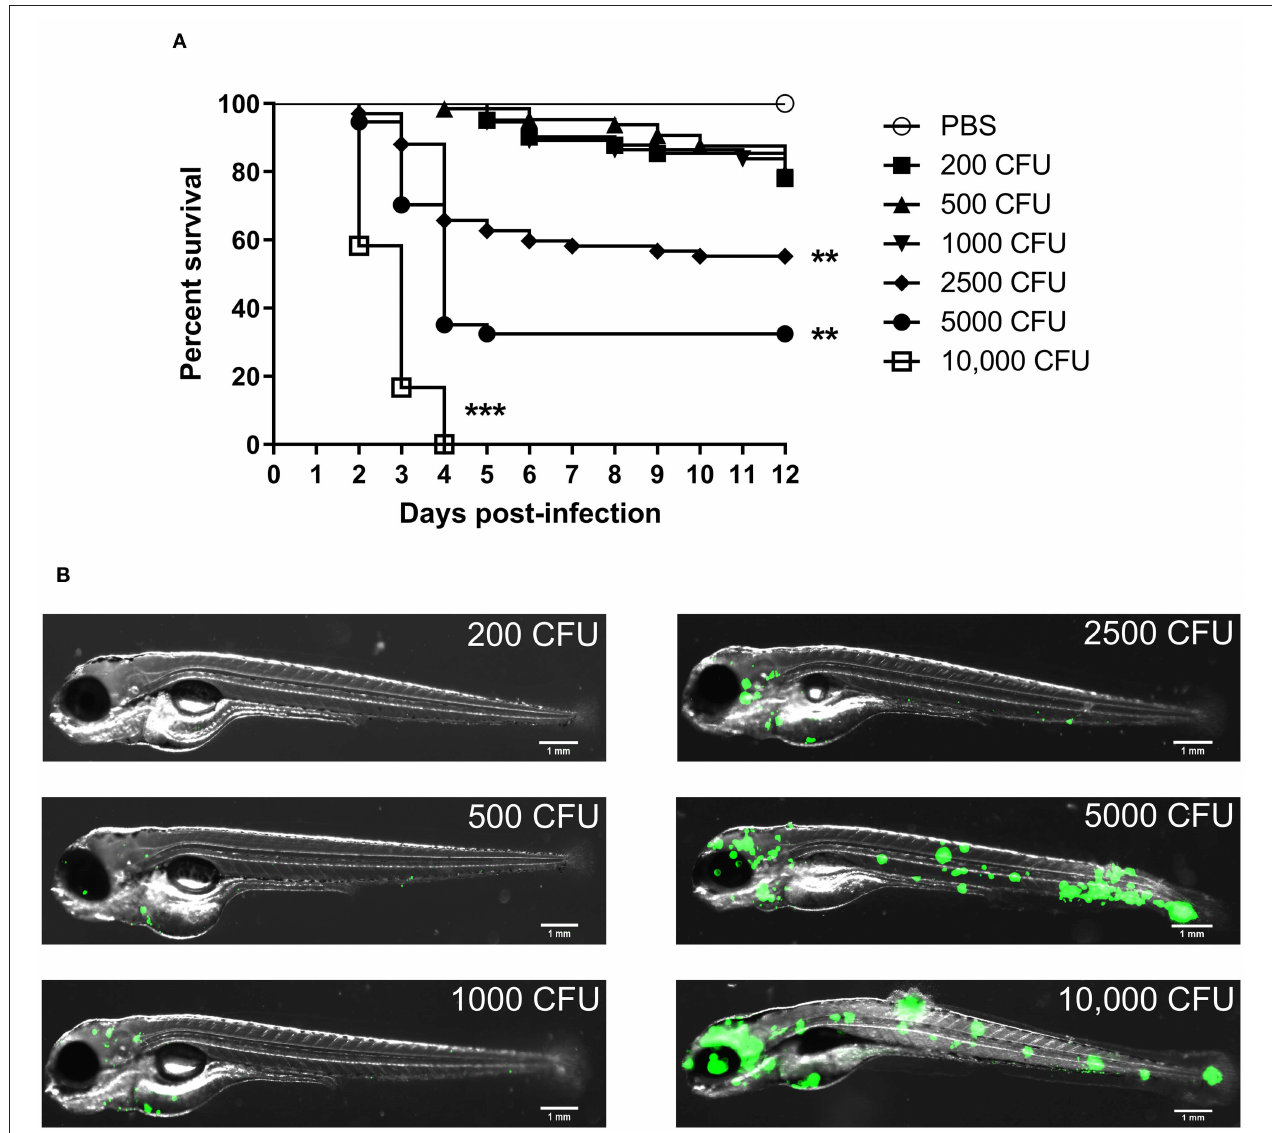
FIGURE 2 | Zebrafish embryos are susceptible to Mycobacterium fortuitum infection in a dose-dependent manner. (A) Zebrafish embryos were injected with varying dosages of GFP-expressing M. fortuitum at 30h post-fertilization via caudal vein injection. Embryo survival was monitored over a 12 day period. N = 20–25 embryos/group. Statistical analysis was completed using the log-rank (Mantel-Cox) statistical test for survival curves. Data shown is the merge of two independent experiments. (B) Representative images of zebrafish embryos infected with varying dosages of GFP-expressing M. fortuitum at 2 days post-infection. Green represents M. fortuitum . Scale bars represent 1mm. ** P ≤ 0.01, *** P ≤